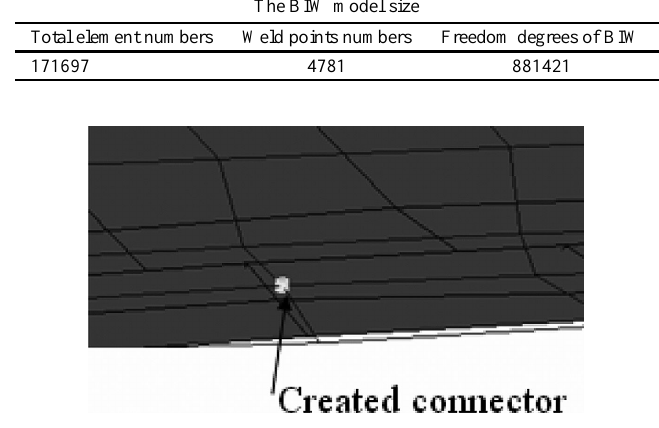
Fig. 2. Created connector.